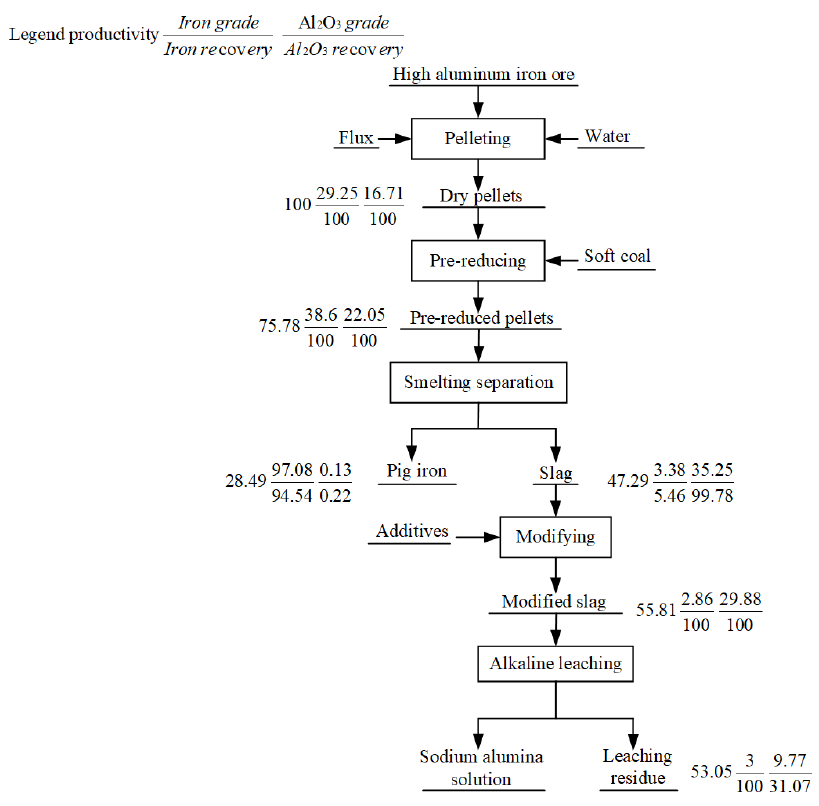
Figure 16. A complete flow sheet for the exergy balance of Fe and Al elements. Table 9. Chemical compositions of pig iron and alkaline leaching tailing (wt. %).